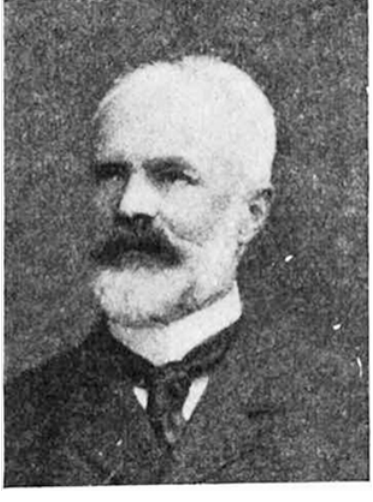
Figure 3 Kazimierz Maksymilian Szafnagel (1858–1923) (Butkiewicz,